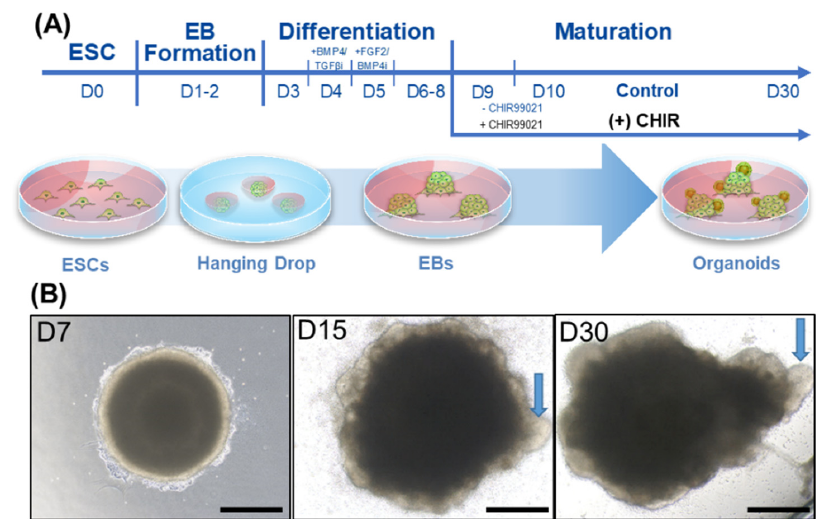
Figure 1. Developmental process of organoids, including hair cell-like cells. ( A ) Generating organ- oids from mouse embryonic stem cells (ESCs). Hanging drop was used to form cell aggregates or